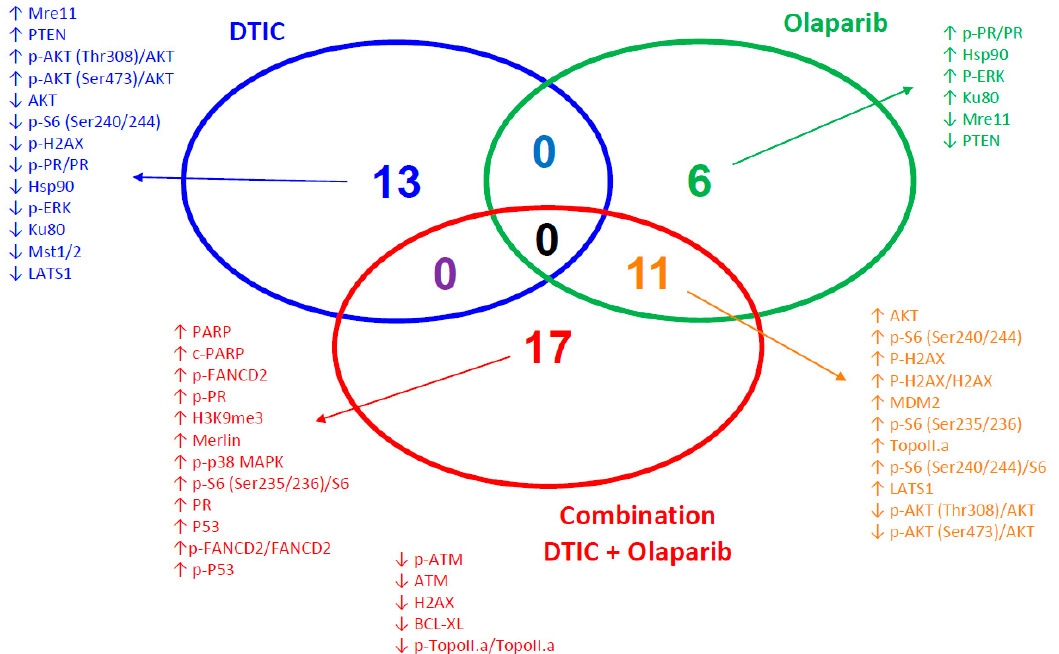
Figure 4. Venn diagram of the proteins significantly ( p < 0.01) correlated to response to DTIC alone (blue) (MP55 + MP77 + MM52 versus MM33), olaparib alone (green) (MM33 versus MP55 + MP77 M MM52), or the DTIC + olaparib combination (red) (MP55 + MP77 + MM33 versus MM52) (paired t tests assuming equal variance).